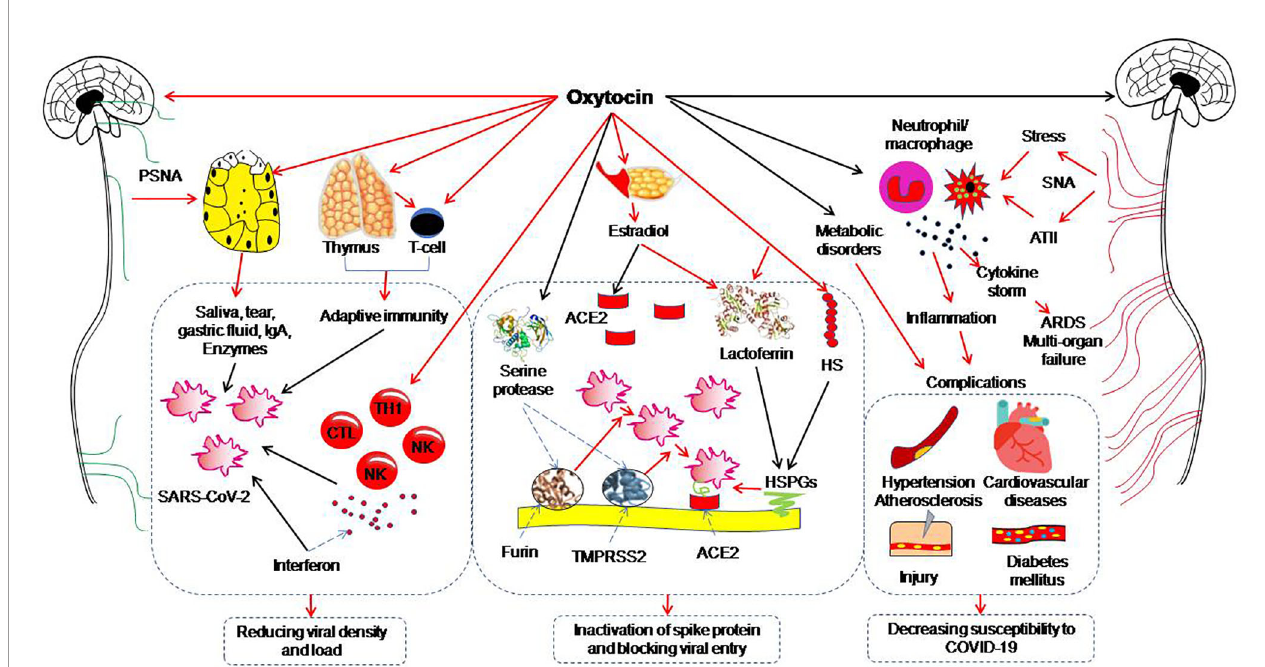
FIGURE 1 | Potential preventive functions of oxytocin against coronavirus disease (COVID-19). The red arrows indicate direct activation; the black arrows indicate direct inhibition. ACE2, angiotensin-converting enzyme 2; ARDS, acute respiratory distress syndrome; ATII, angiotensin II; CTL, cytotoxic T lymphocyte; HS, heparan sulphate; HSPG, heparan sulphate proteoglycan; IgA, immunoglobulin A; NK, nature killer cell; PSNA, parasympathetic nerve activation; SARS-CoV-2, severe acute respiratory syndrome coronavirus 2; SNA, sympathetic nerve activation; TH1, T helper cells 1; TMPRSS2, Transmembrane protease serine 2. [Figure is original drawing; also refer to references (96, 100 –